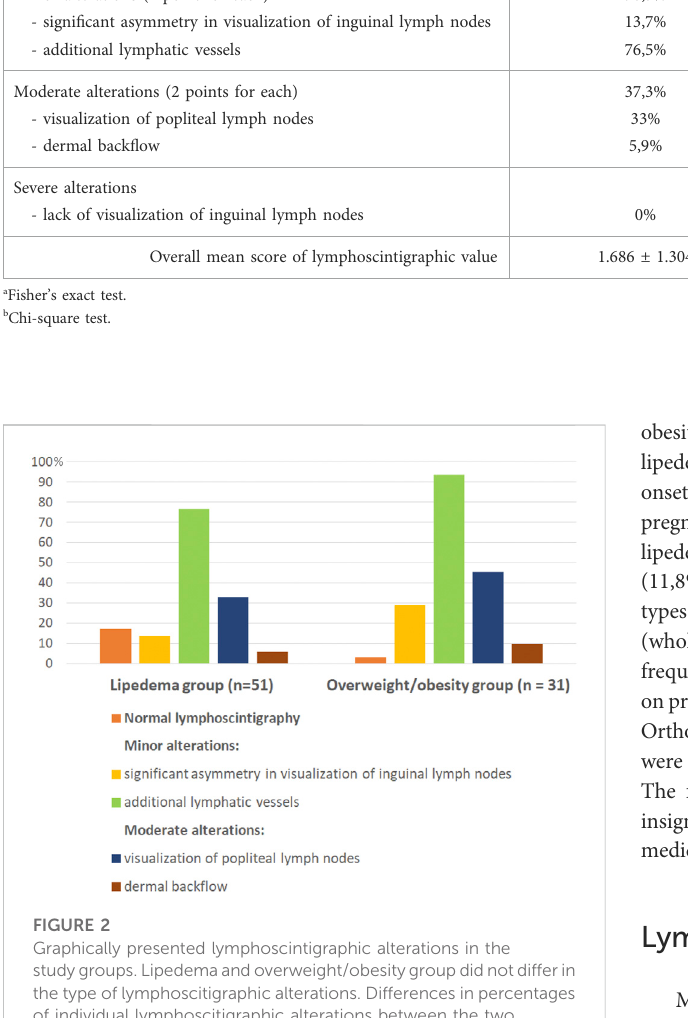
lymphoscintigraphy values (ordinal variable) and stage of lipedema (ordinal variable). p -values less than 0.05 were considered statistically signi fi cant. IBM SPSS Statistics software (version 29.0) and GraphPad Prism version 9.4.1 (GraphPad Software) were used for analyses.